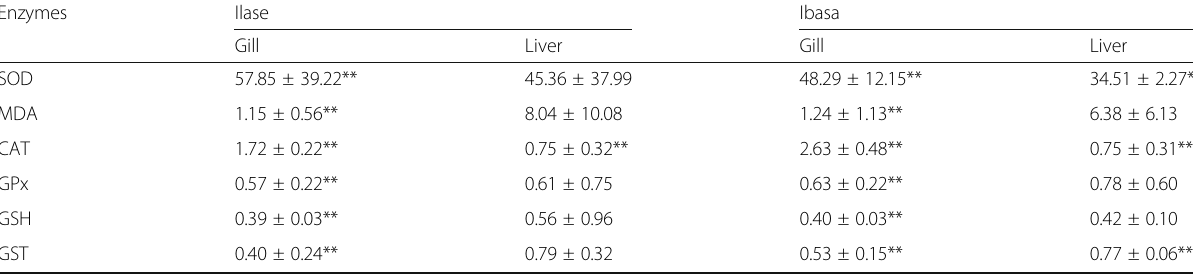
Table 8 Antioxidants and lipid perioxidation in Ibasa and Ilase creeks, Snake Island, Lagos